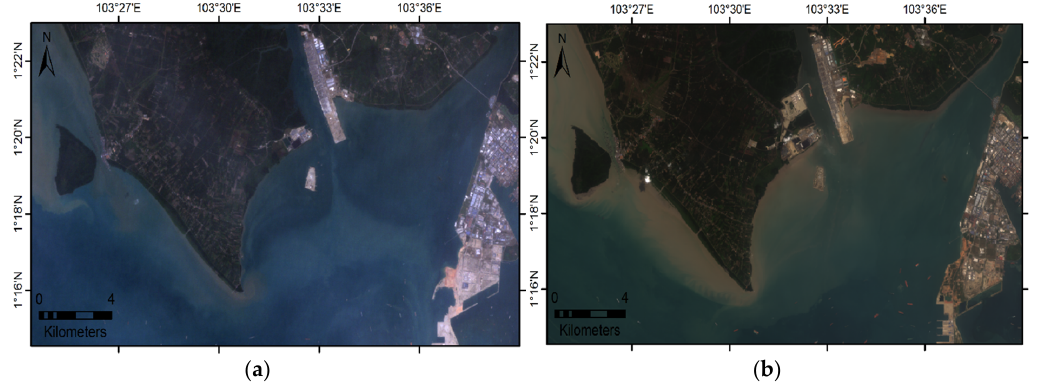
Figure 2. Study area viewed from ( a ) Landsat 5 TM; and ( b ) Landsat 8 OLI (path/row: 125/59). Both the scenes are loaded in natural color composites by layer stacking bands 3, 2, 1 for TM and bands 4, 3, 2 for